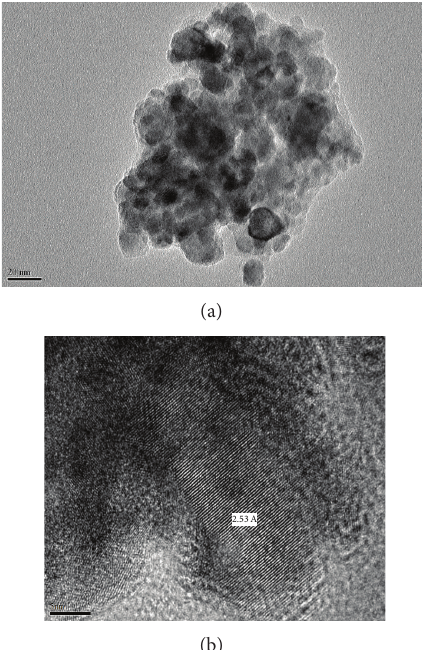
Figure 4: (a) TEM and (b) HRTEM images of sample milled for 40 h.